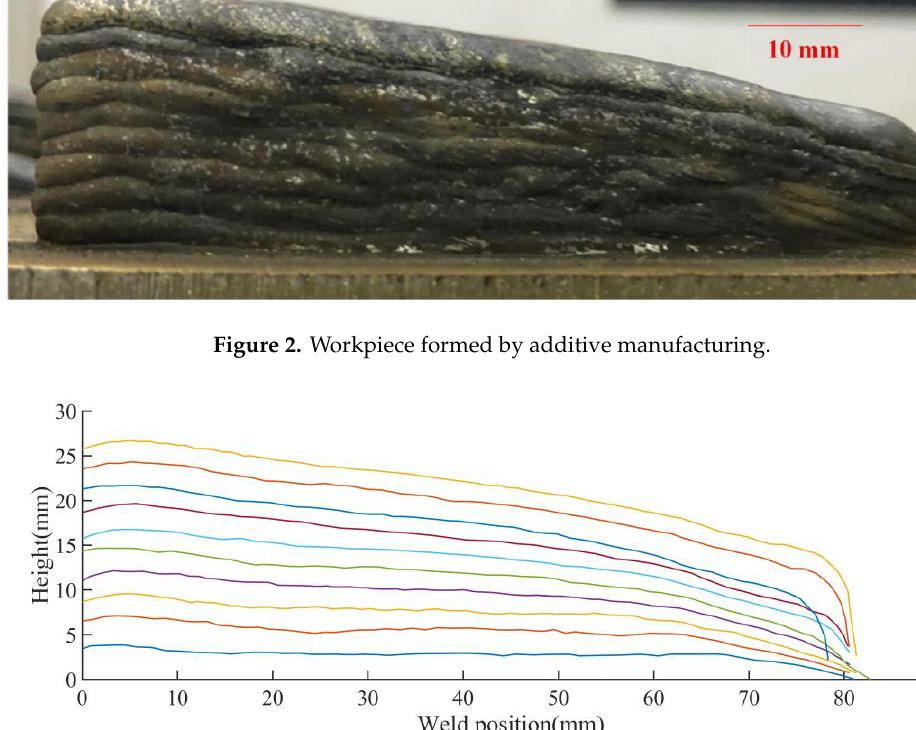
Figure 3. The geometric dimensions of the workpiece.